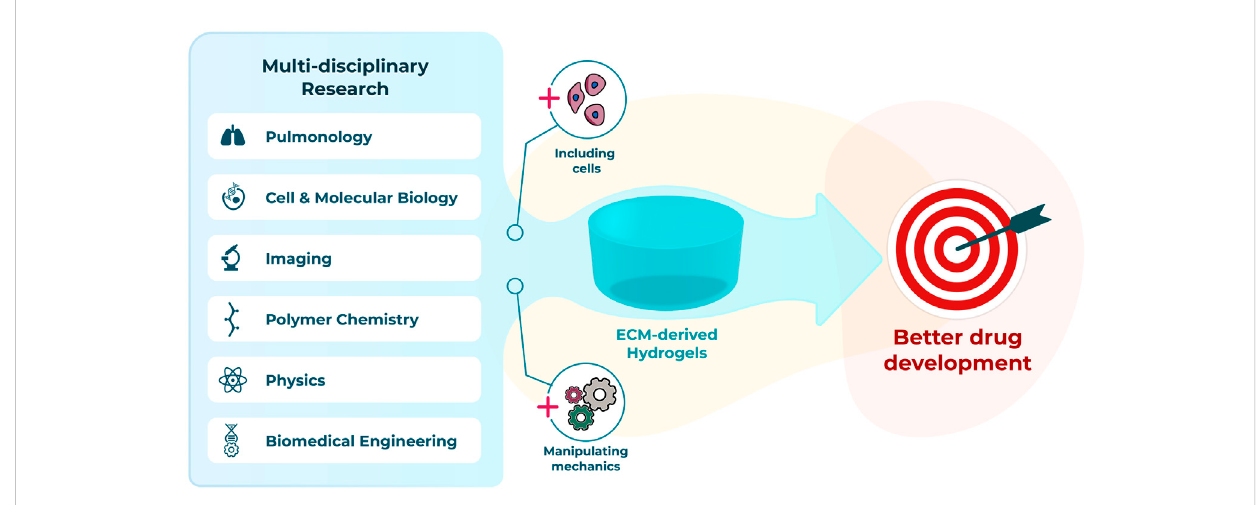
FIGURE 2 Interdisciplinary advances to progress towards a better preclinical model using